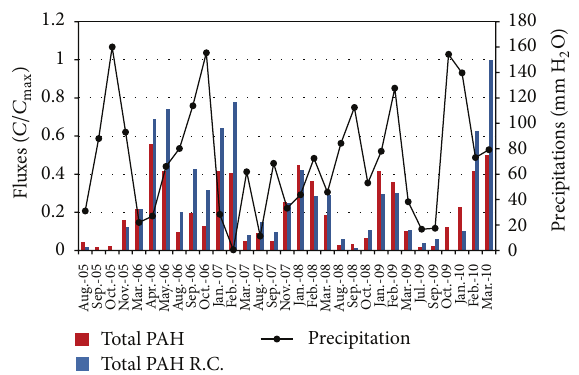
Figure 10: Average depositions of inorganic micropollutants for deposimeters D4 grouped according to